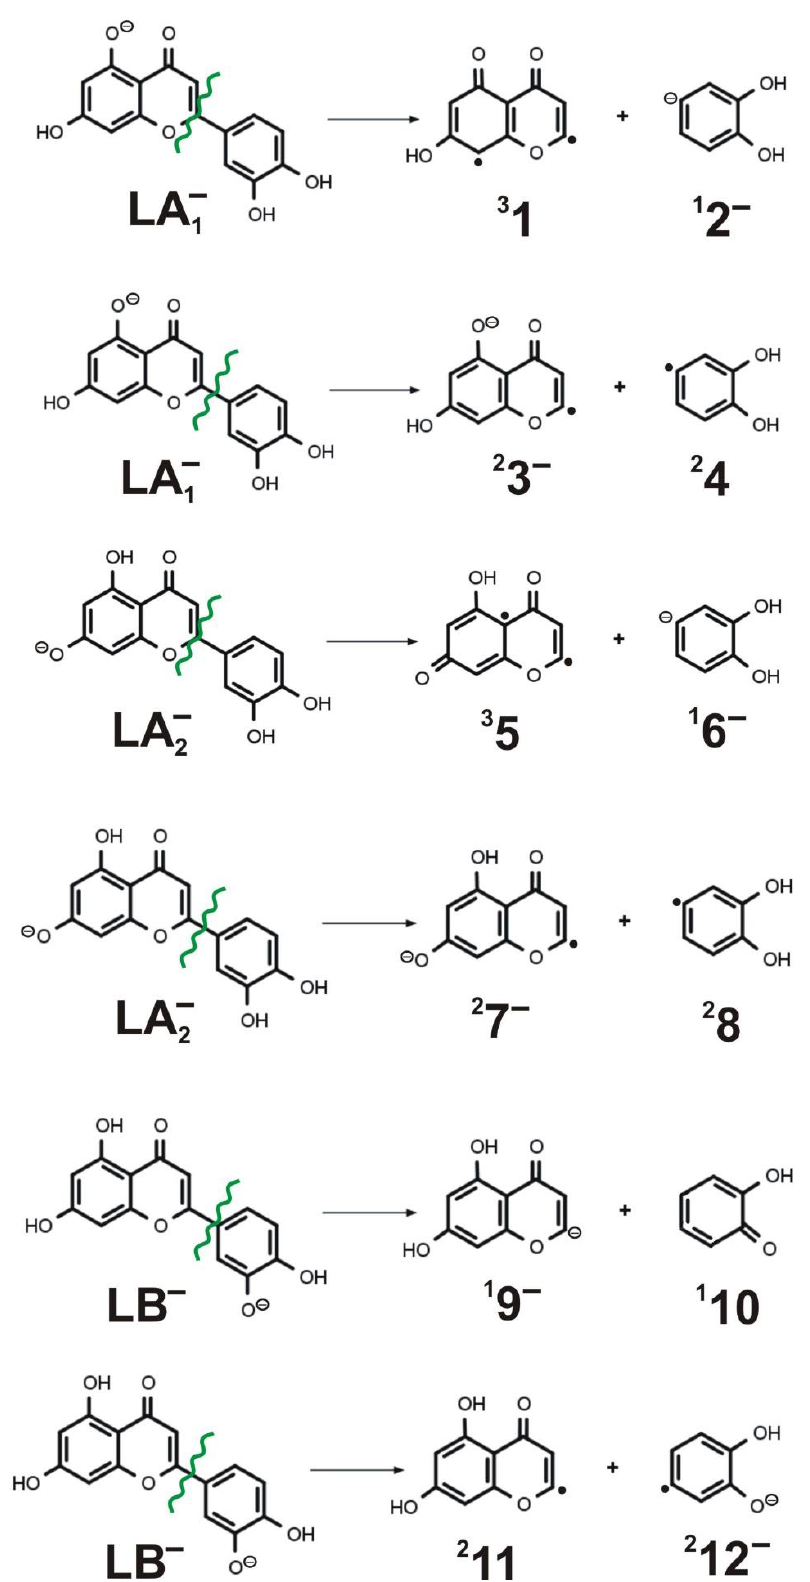
Figure 9. The fragmentations of LA 1- , LA 2- , and LB - caused by either heterolytic or homolytic cleavage of the C-C bond connecting C and B rings. Spin multiplicity and the charge of the 1 – 12 products are indicated in the left and right superscript, respectively.